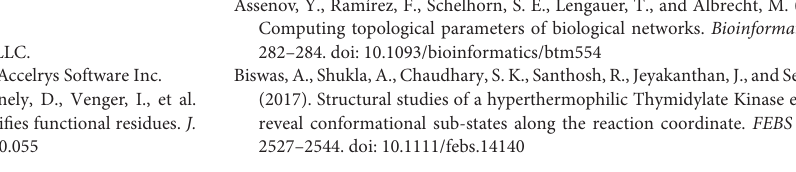
Figure S1 | Binding mode between different forms of inositol phosphates and the COI1-ASK1-JAZ1 complex predicted by molecular docking. The carbon atom and oxygen atoms of inositol phosphates and JA-Ile are colored in green and red, phosphorus atoms of inositol phosphates colored by orange, respectively. Hydrogens are omitted for clarity. (A) COI1 + ASK1 + JAZ1 + JA-Ile + InsP 5 [3-OH]. (B) COI1 + ASK1 + JAZ1 + JA-Ile+InsP 6 . (C) COI1 + ASK1 + JAZ1 + JA-Ile+1,2-InsP 8 . (D) COI1 + ASK1 + JAZ1 + JA-Ile + 1,5-InsP 8